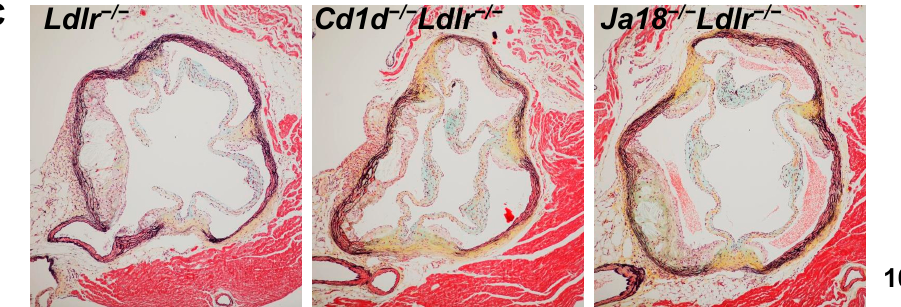
Figure 5. Aortic atherosclerosis is increased in obese Ja18 − / − Ldlr − / − mice. ( A ) Quantitation of aortic intimal lesions; ( B ) Quantitation of aortic sinus lesions; ( C ) Photomicrographs of Movat’s pentachrome stained aortic sinus lesions. 10 × magnification. n = 6–8 per group, ** p < 0.01 vs. HFHSC-fed Ldlr − / − mice, # p < 0.05 vs. HFHSC-fed Cd1d − / − Ldlr − / − mice.